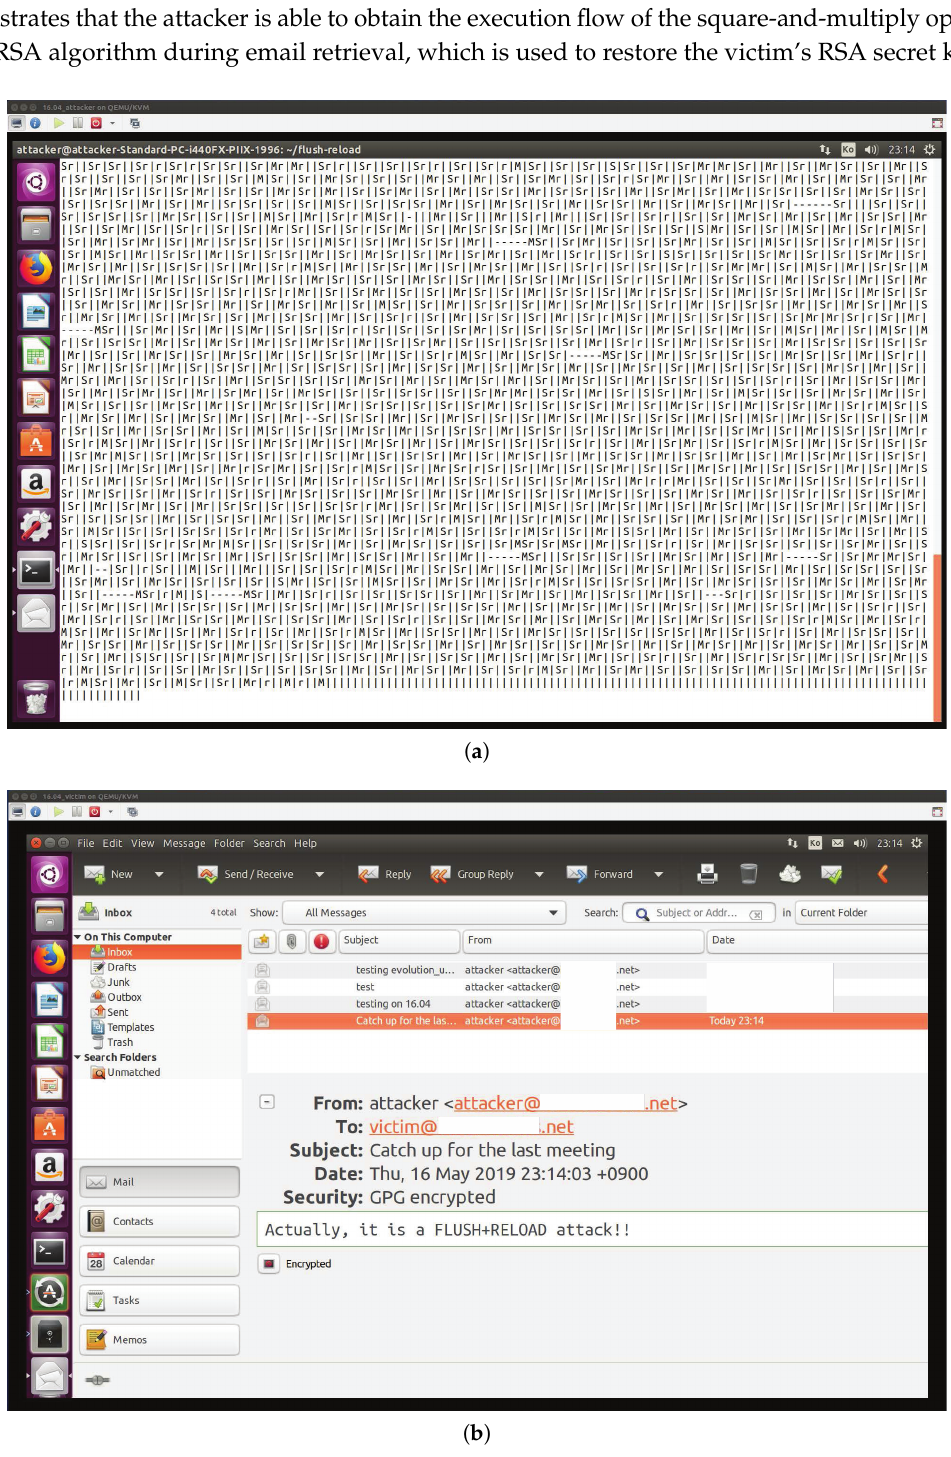
Figure 3. Attack on Evolution MUA: ( a ) Attacker’s view. ( b ) Victim’s